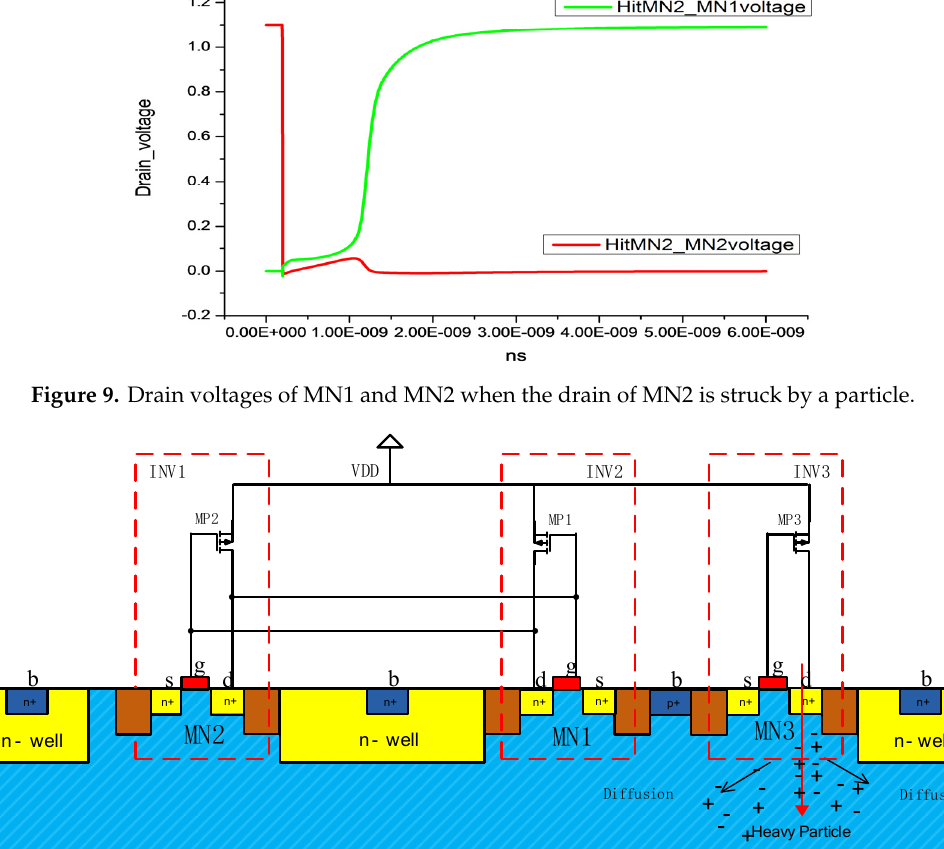
Figure 10. A particle strikes the drain central region of MN3 transistor perpendicularly. Cross-sections of layout in a cell of SRAM.